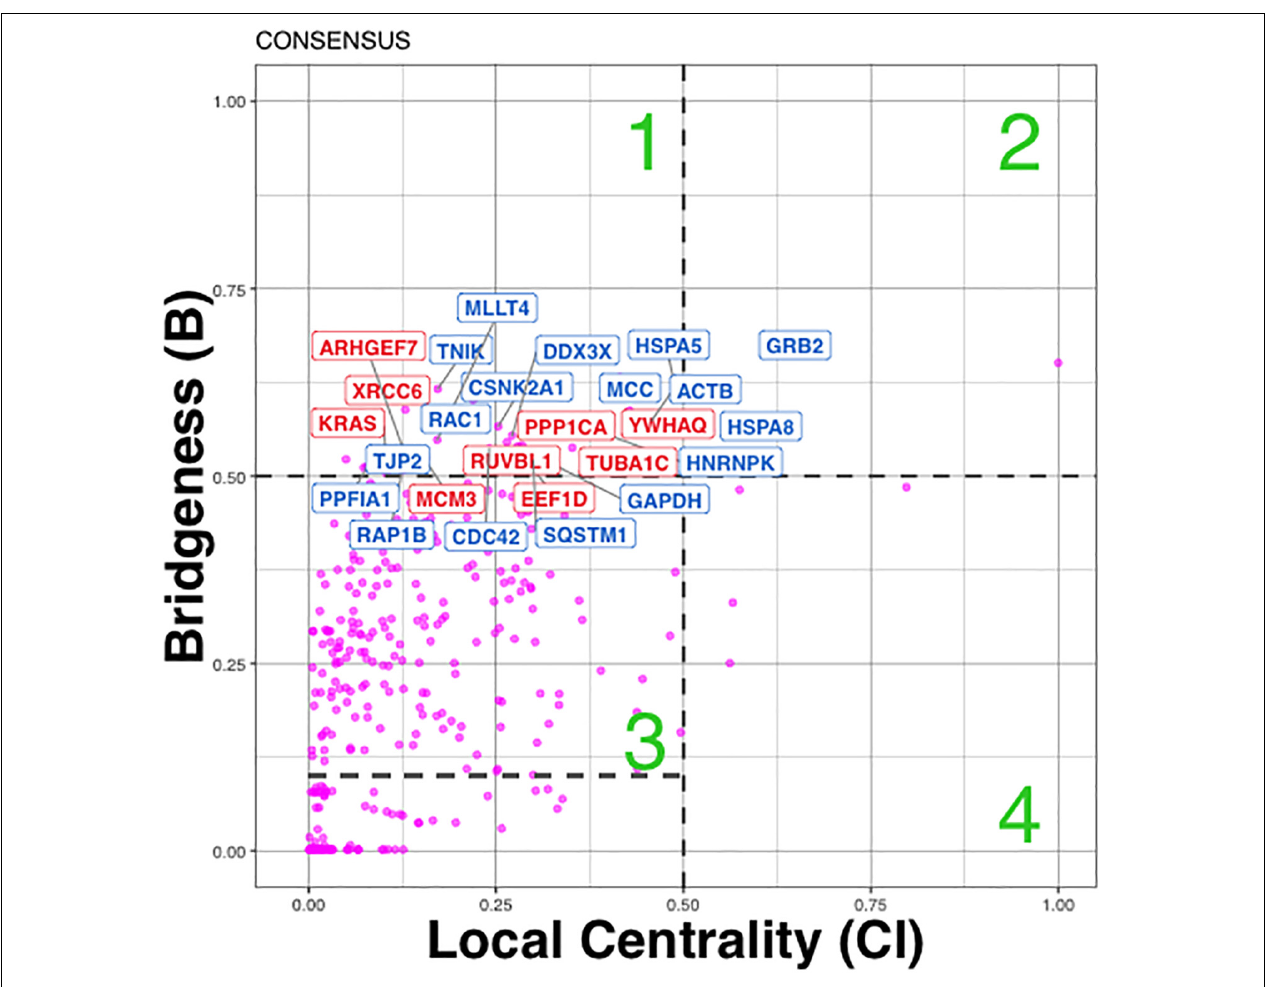
FIGURE 5 | Distribution of influential/bridging proteins in cancer p140Cap networks estimated from consensus clustering results. Proteins were divided into four quadrants or regions labeled 1–4: (1) Bridging proteins with ’global’ rather than ’local’ influence (also been called bottle-neck bridges. (2) Bridging proteins with mixed “global” and “local” influence in the network. (3) Proteins important primarily within one or two communities. (4) Proteins that influence just “locally” in the network. Red color corresponds to Bridging proteins annotation with cancer- related diseases only, blue – to proteins annotated with both cancer and neurological